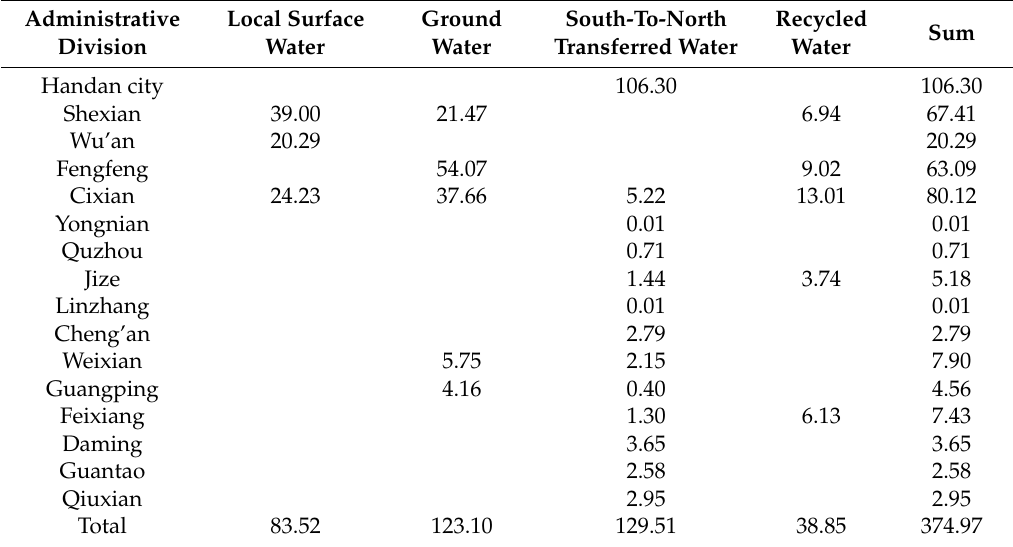
Table 12. Surplus volumes not allocated (10 6 m 3 ).